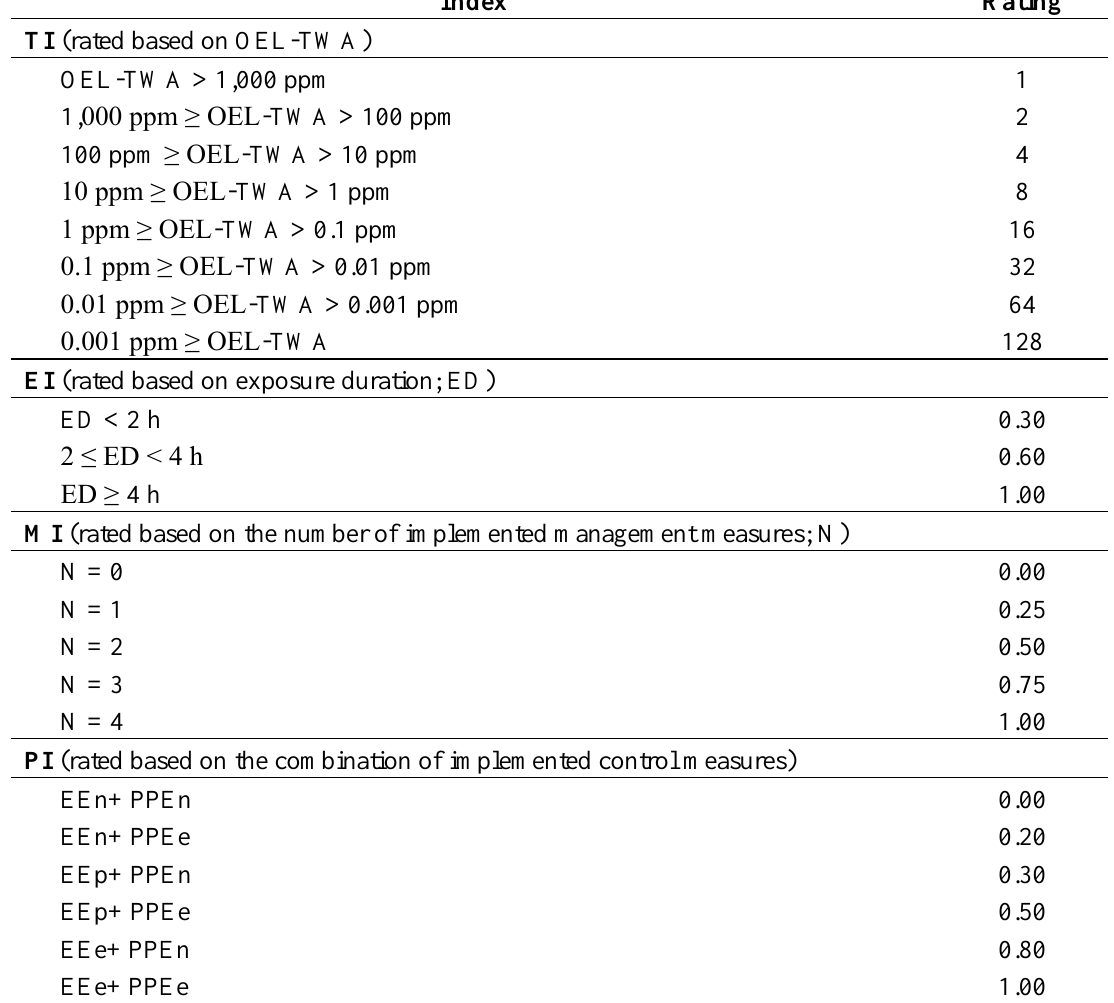
Table 1. Originally proposed ratings for toxicity index (TI), exposure index (EI), management index (MI) and protection index